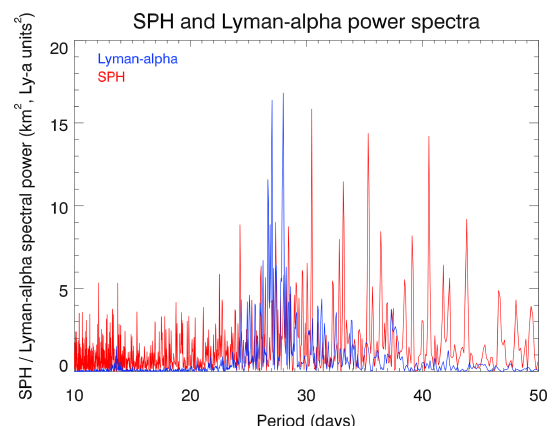
Figure 3. Power spectra of the Lyman- α and the standard phase height (SPH) time series starting in February